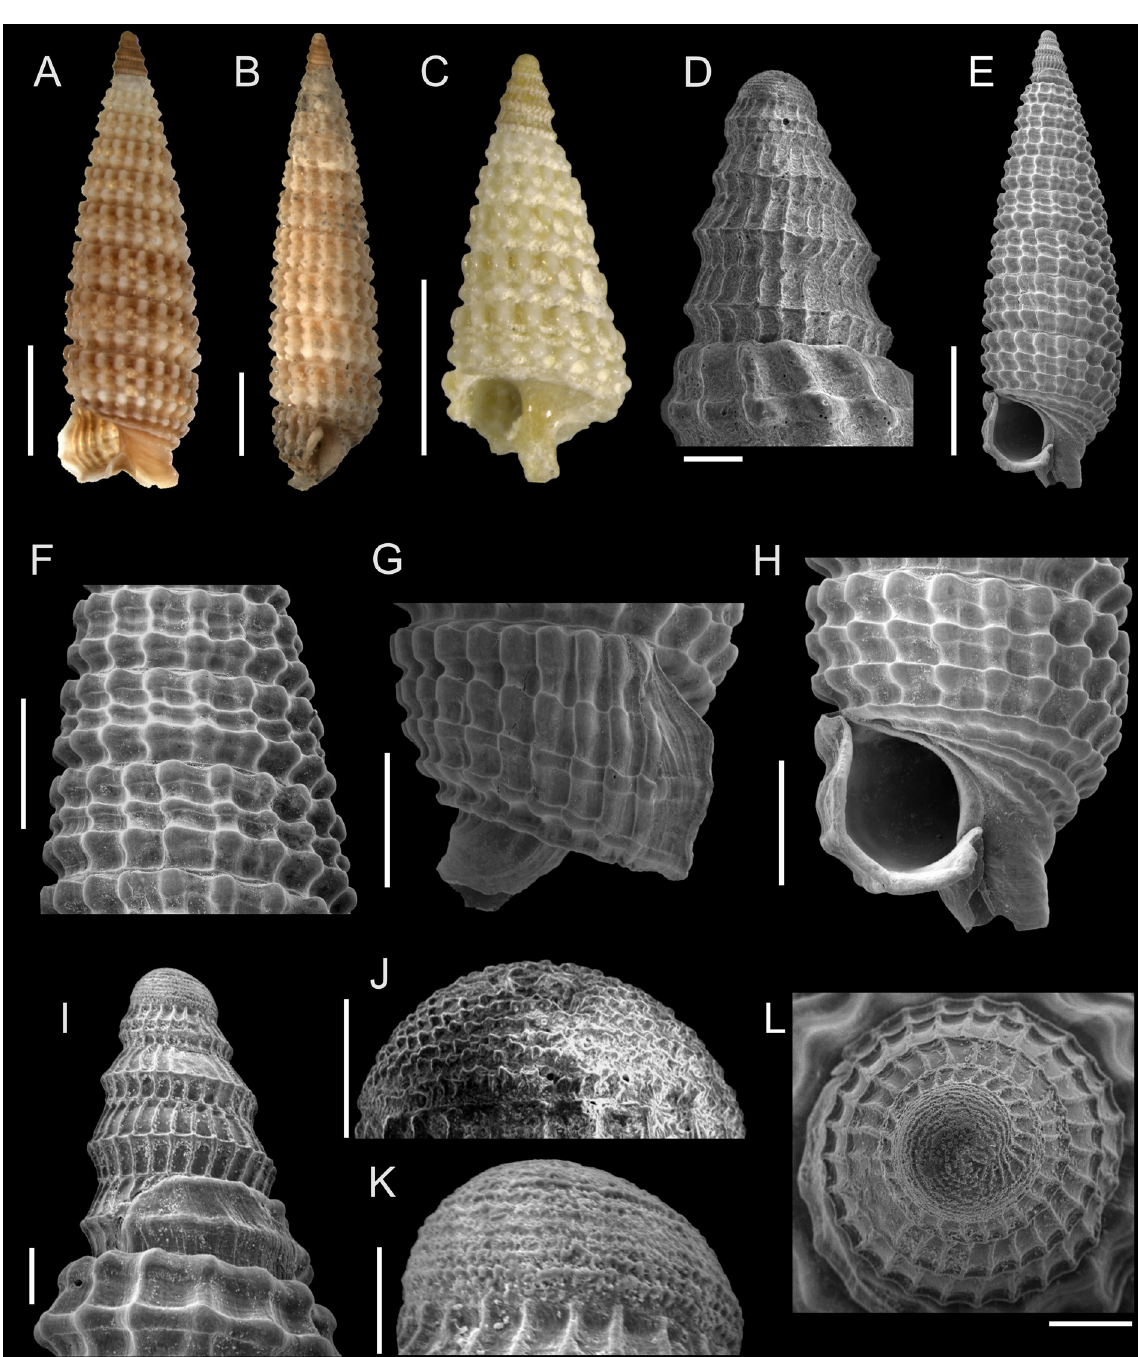
Fig. 11. Monophorus verecundus sp. nov. A . MNRJ 18383*, holotype, 4.24 mm. B . MNRJ 19479*, 5.40 mm. C . MNRJ 35114*, 2.47 mm. D, J . Same shell as C. E–I, K–L . Holotype. Scale bars: A–C, E = 1 mm; D, I, L = 100 µm; F–H = 500 µm; J–K = 50